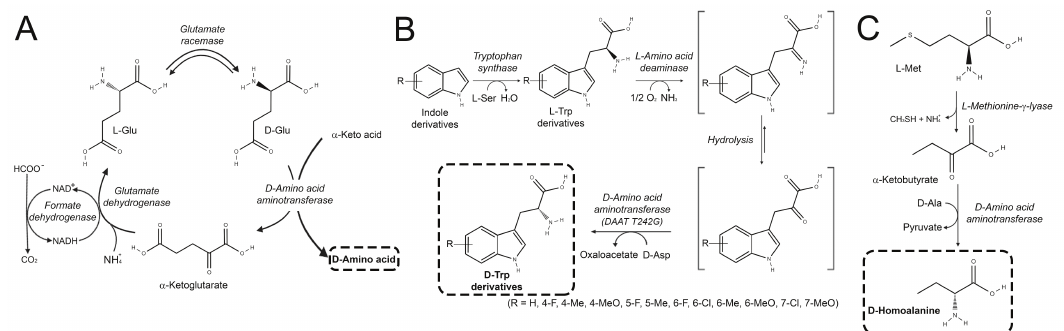
Figure 1. Use of aminotransferases in production of D-AAs. Synthesis of D-AAs from the corresponding α -keto acids and ammonia by coupling: ( A ) four enzymes, namely D-amino acid aminotransferase, glutamate racemase, glutamate dehydrogenase and formate dehydrogenase [11]; ( B ) tryptophan synthase from S. enterica, L-amino acid deaminase from P. myxofaciens and T242G variant of D-aminotransferase variant from Bacillus sp. YM-1 for the synthesis of D-tryptophan derivatives [12]; ( C ) L-methionine γ -lyase from F. nucleatum and D-amino acid aminotransferase from Bacillus sp. to convert L-methionine into D-homoalanine